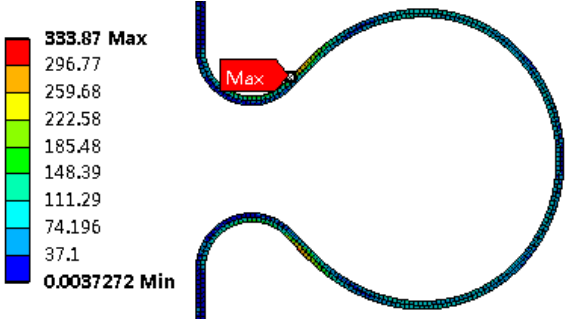
Figure 9. Von Mises equivalent stress distribution after unloading (MPa).